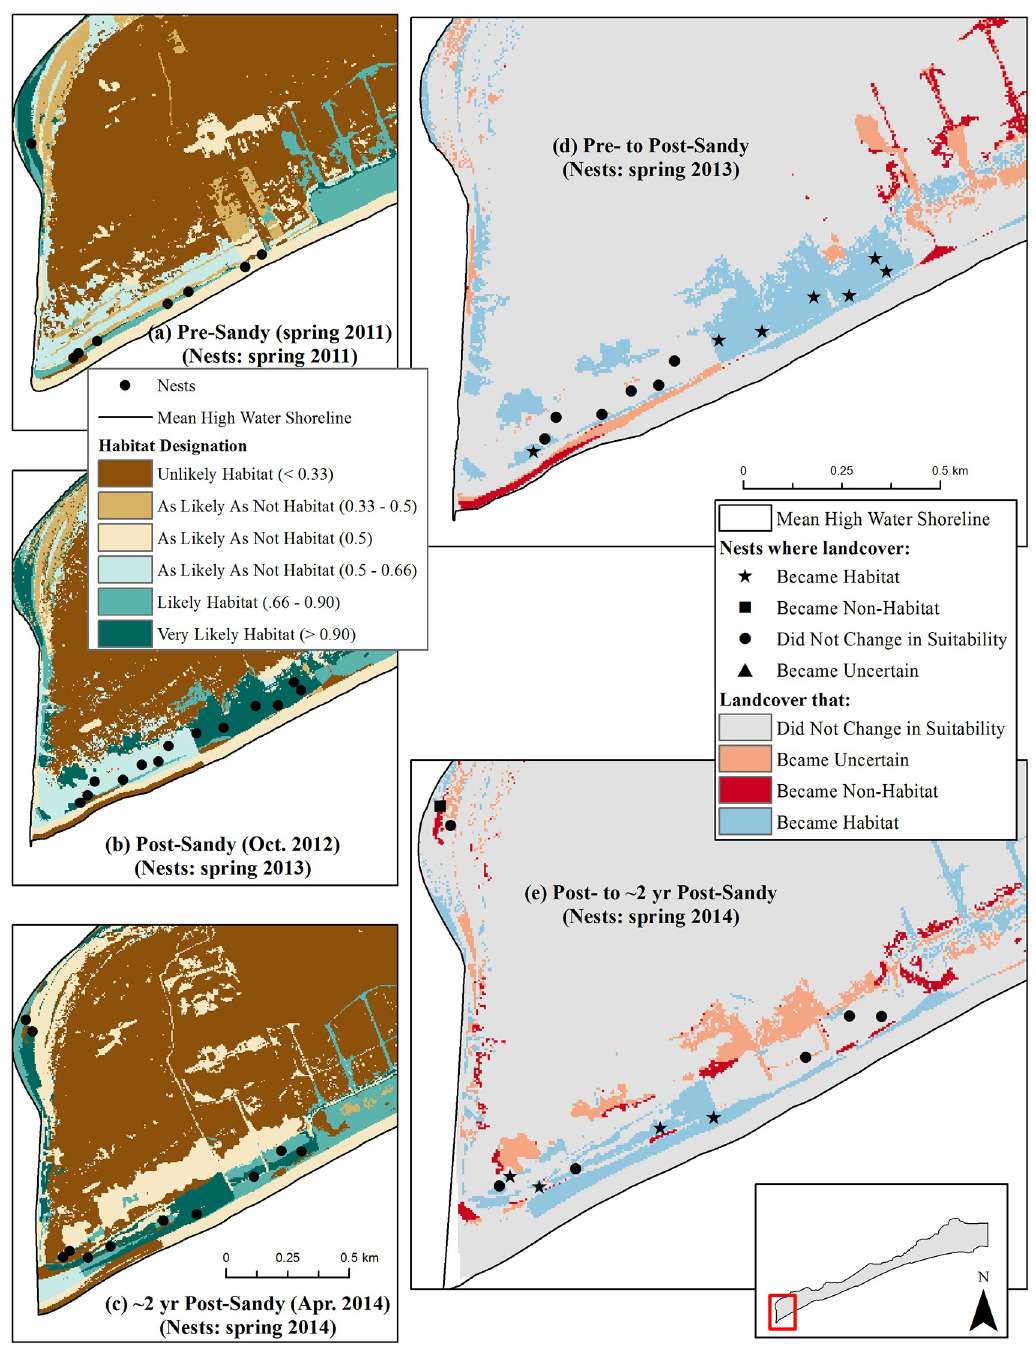
Fig 5. Examples of habitat change before Hurricane Sandy, immediately following Sandy, and ca. 2 years post-Sandy within the Rockaway Peninsula, New York, study area. Maps (a)-(c) show habitat in the year corresponding with the aerial imagery used for analysis, with piping plover nest points corresponding to the breeding season for which habitat was available 1 . Map (d) shows changes in habitat that ostensibly resulted from Hurricane Sandy, while map (e) shows changes in habitat since the hurricane occurred 2 . 1 Nest points contributed by [68] 2 See footnotes accompanying Fig 4.